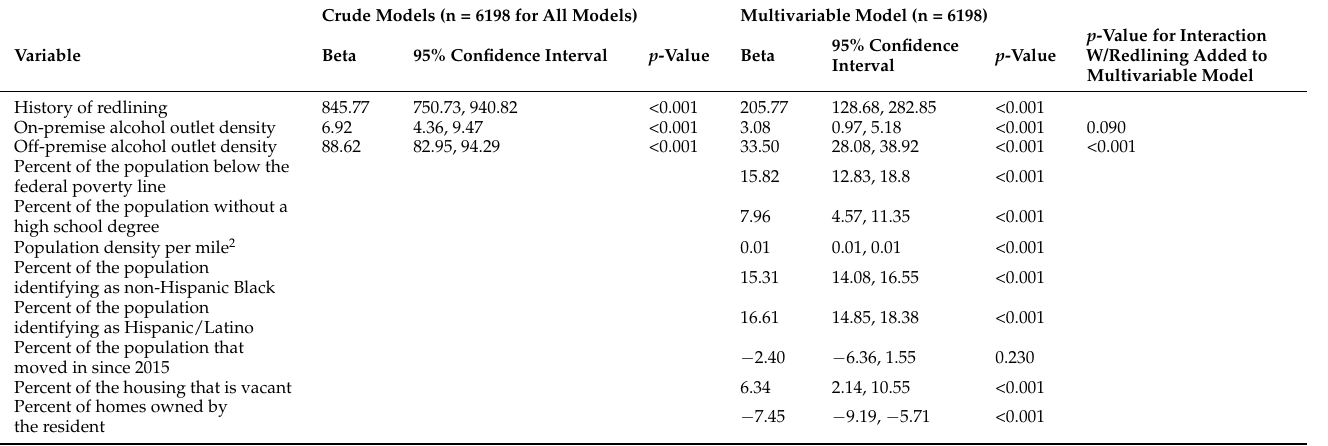
Table 2. Linear regression models examining the association of redlining, on-premise and off-premise alcohol outlet density, and covariates with